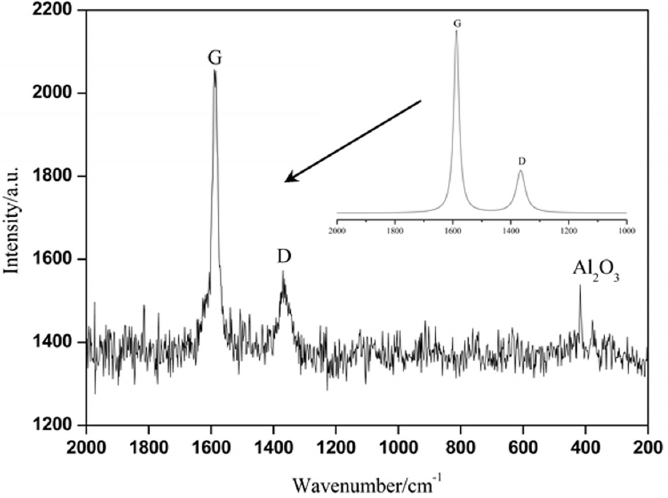
Figure 6. Raman spectrum of the composites.